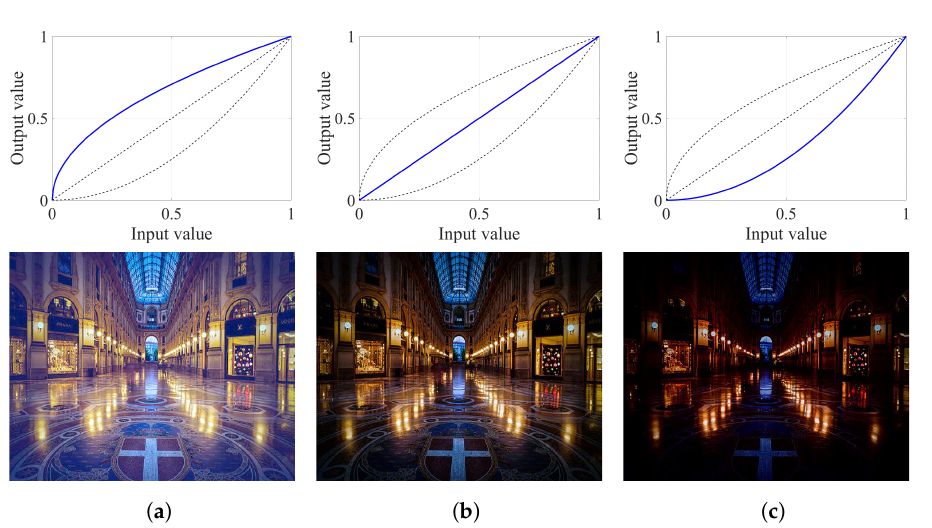
Figure 1. Gamma correction curves and corresponding effects on an image: ( a ) γ = 0.5, ( b ) γ = 1, and ( c ) γ =